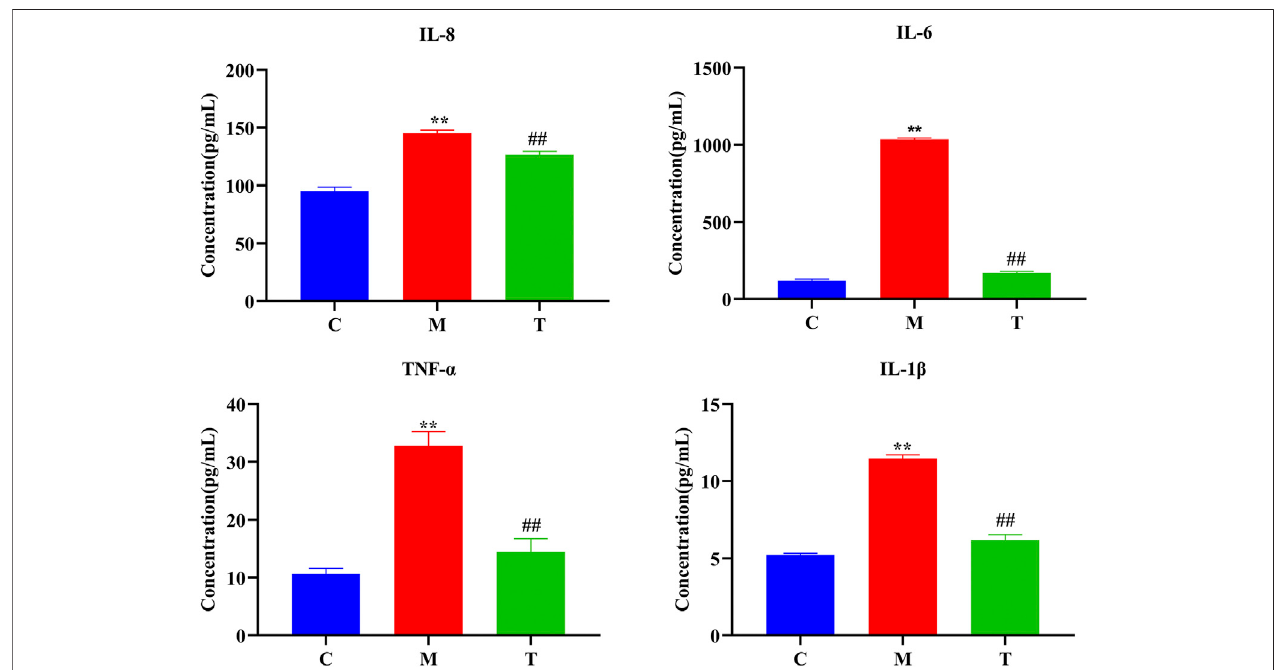
FIGURE 4 | Expression levels of the serum in fl ammatory factors interleukin (IL)-8, IL-6, IL- β , and tumor necrosis factor alpha (TNF- α ) (**, p < 0.01 vs. C rats; ##, p < 0.01 vs. M rats).